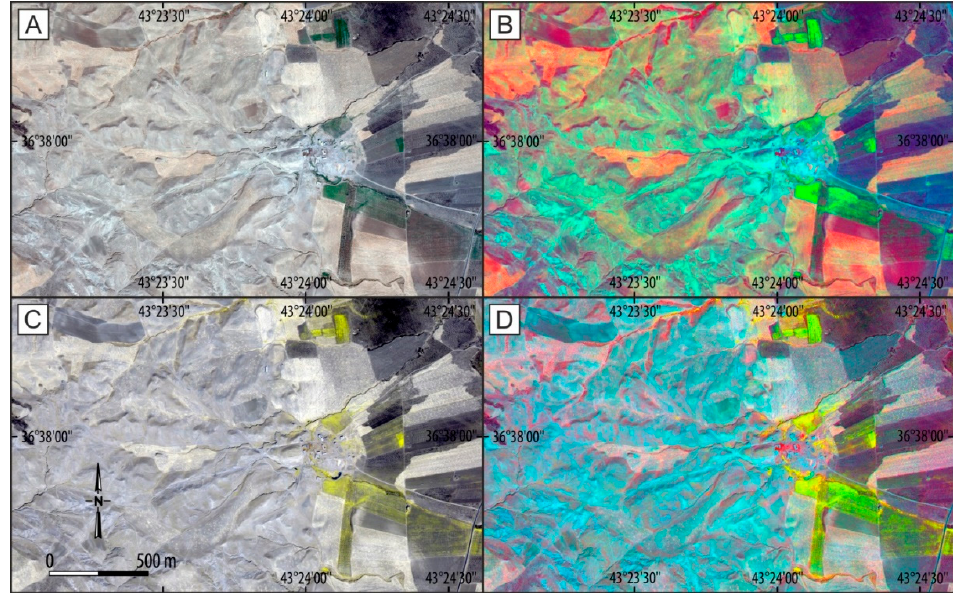
Figure 7. The implementation of decorrelation stretch for CC 235 (TC) ( A , B ) and FCC 478 ( C , D ); the original HPF composites are on the left ( A , C ), while those after enhancement are on the right ( B , D ) (ID10300100388F8C00). WorldView ‐ 2 © 2014 DigitalGlobe, Inc., Westminster, Colorado, USA.